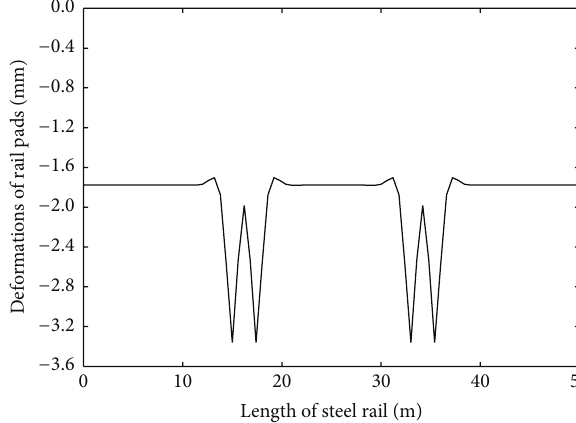
Figure 4: The compressive deformations of TPE rail pads at the different positions of a rail under a rail-fastener preload of 20 kN and the half of vehicle weight (320